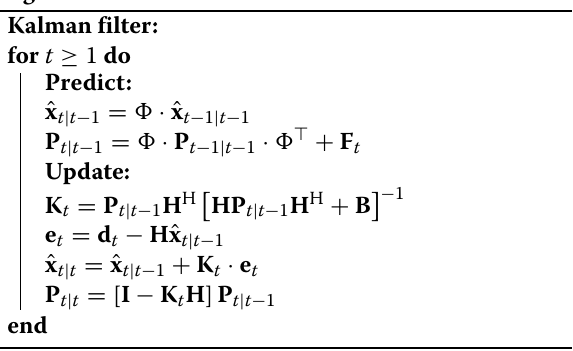
Algorithm 1: The Kalman